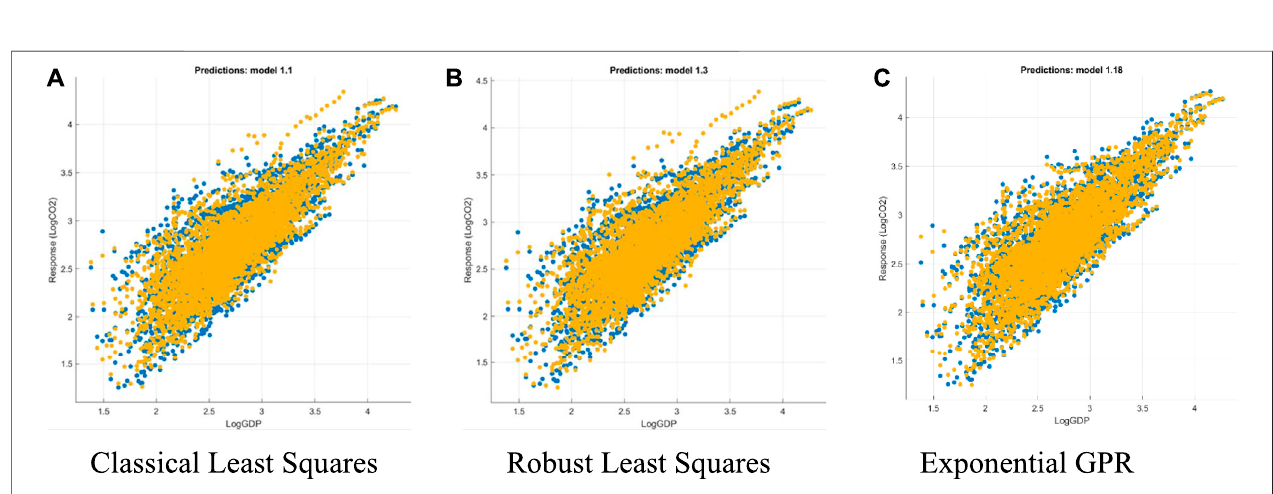
FIGURE 3 | Comparing actual and predicted CO 2 emissions against GDP of the selected models. (A) Classical Least Squares. (B) Robust Least Squares. (C) Exponential GPR. Notes: 1) The vertical axis denotes the value of CO2 emissions in the logarithm. 2) The horizontal axis denotes the value of GDP in logarithm. 3) CO 2 emissions are measured in 10,000 tons of standard coal. 4) The blue dots represent actual values whereas the yellow dots represent the predicted values. (5) GDP is measured in 100 million Chinese Yuan.